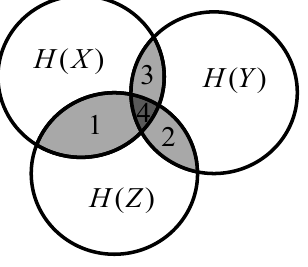
Figure 2. Venn diagrams of mutual information (MI).